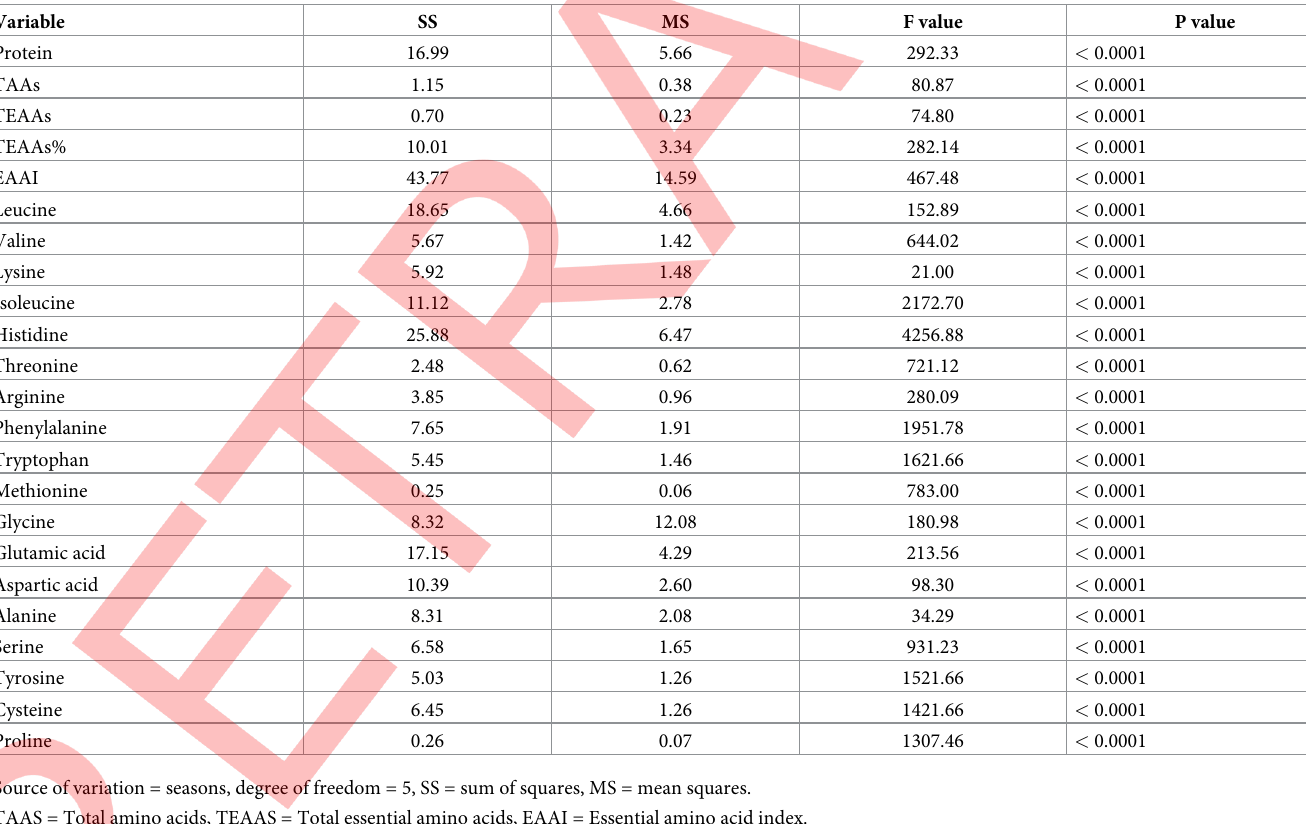
Table 2. Analysis of variance of protein and amino acids contents of bee pollen.